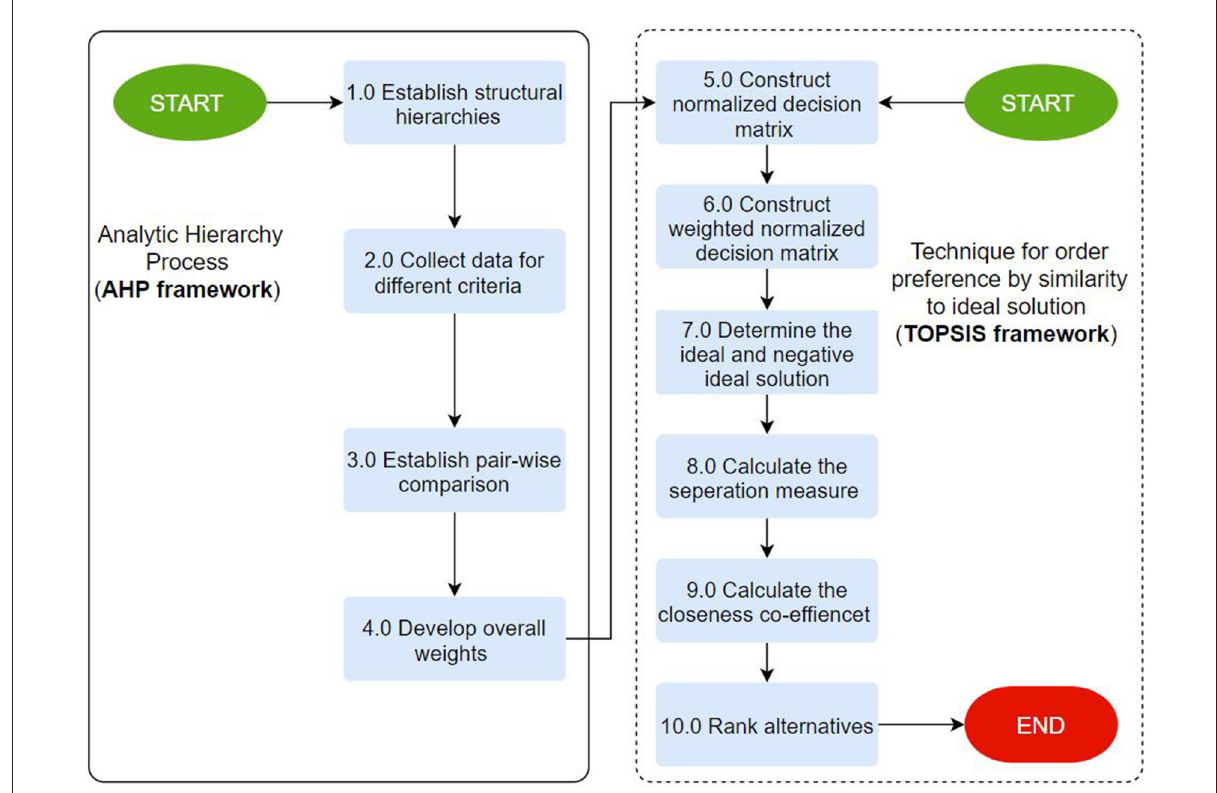
FIGURE3 An integrated AHP-TOPSIS from selecting optimal diet concepts in the United States.